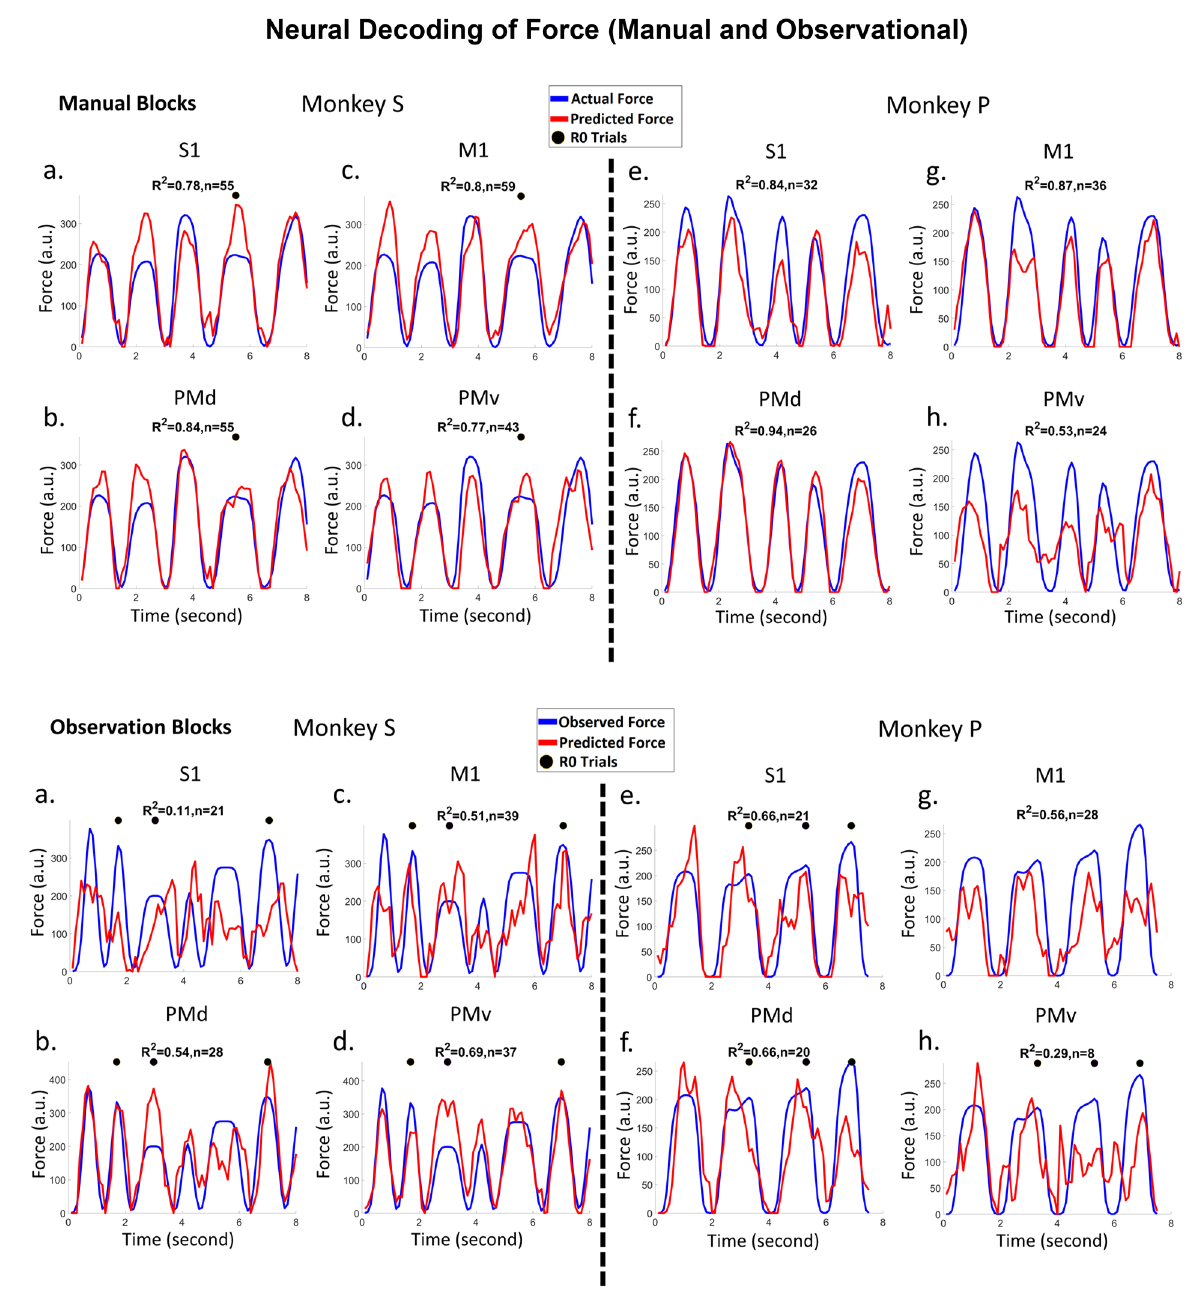
Figure 5. Force decoding (Red lines) from subpopulations of cS1, rM1, PMd, and PMv cortical recordings taken from manually performed blocks top two rows, and observational blocks bottom two rows. Linear regression (eq. 2) was used to predict the force from a subpopulation (see methods). The black dots on each plot indicate that the force profile was taken from an R0 trial, while all others were R1 trials. Plots a, b, c, and d show results for NHP S, for cS1, rM1, PMd, and PMv cortices, respectively. Plots e , f, g, and h show similar results for NHP P. The top of each figure shows R-squared values (R 2 ) using the 10% test set and the number (n) of significant units used for regression to predict force. See Table S2 for full stats on the regression least-squares estimates from 90% of the recorded data (see Fig. S5 for data split cartoon). The remaining 10% of the data was used as a test set to verify the performance of force decoding. The R-squared values for decoding on the test set of forces are shown below. We found high prediction accuracies for both NHPs. The results shown in Fig. 5 are force decoding prediction from cS1, rM1, PMd, and PMv cortices for cued manual blocks, top two rows, with the corresponding observational blocks seen in the bottom two rows. Note that intertrial intervals have been clipped out for presentation purposes.